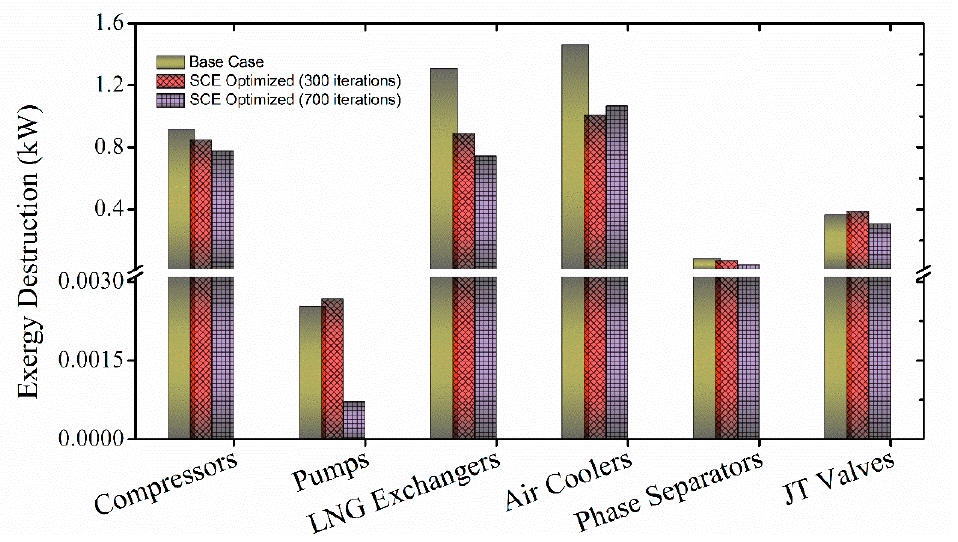
Figure 7. Disintegrated exergy destruction (%) for the base case and SCE-optimized MFC–LNG process.